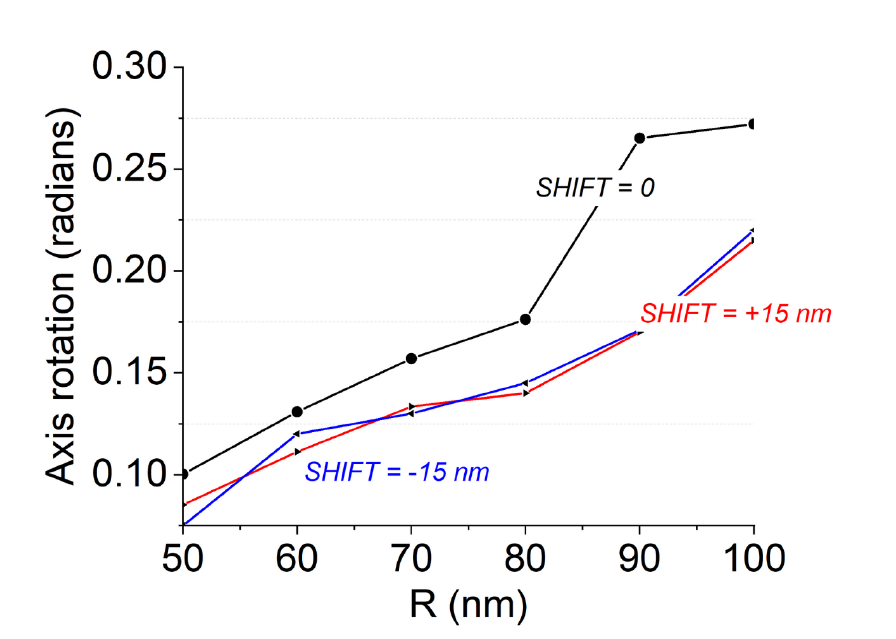
Figure 3. Optical axis rotation introduced by the addition of a NW to a standard waveguide to break the device symmetry; the blue and red curves show results obtained by shifting the horizontal position of